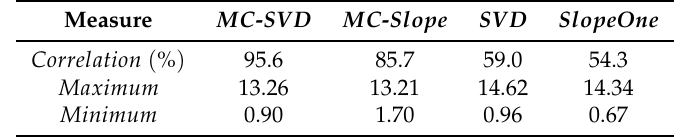
Table 8. Correlations between actual and predicted ratings.